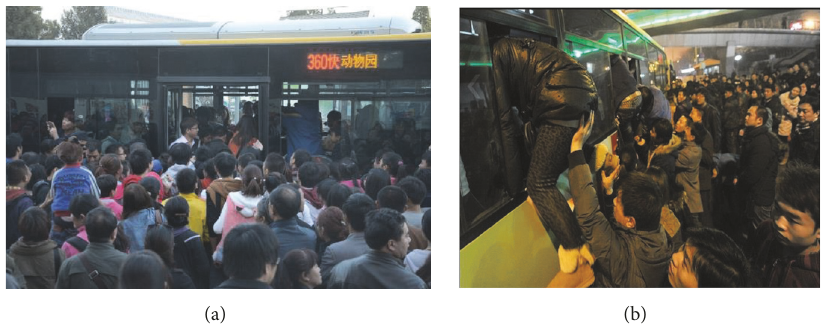
Figure 1: Crowding at the bus stop. (a) Queuing for a bus line. (b) Climbing by